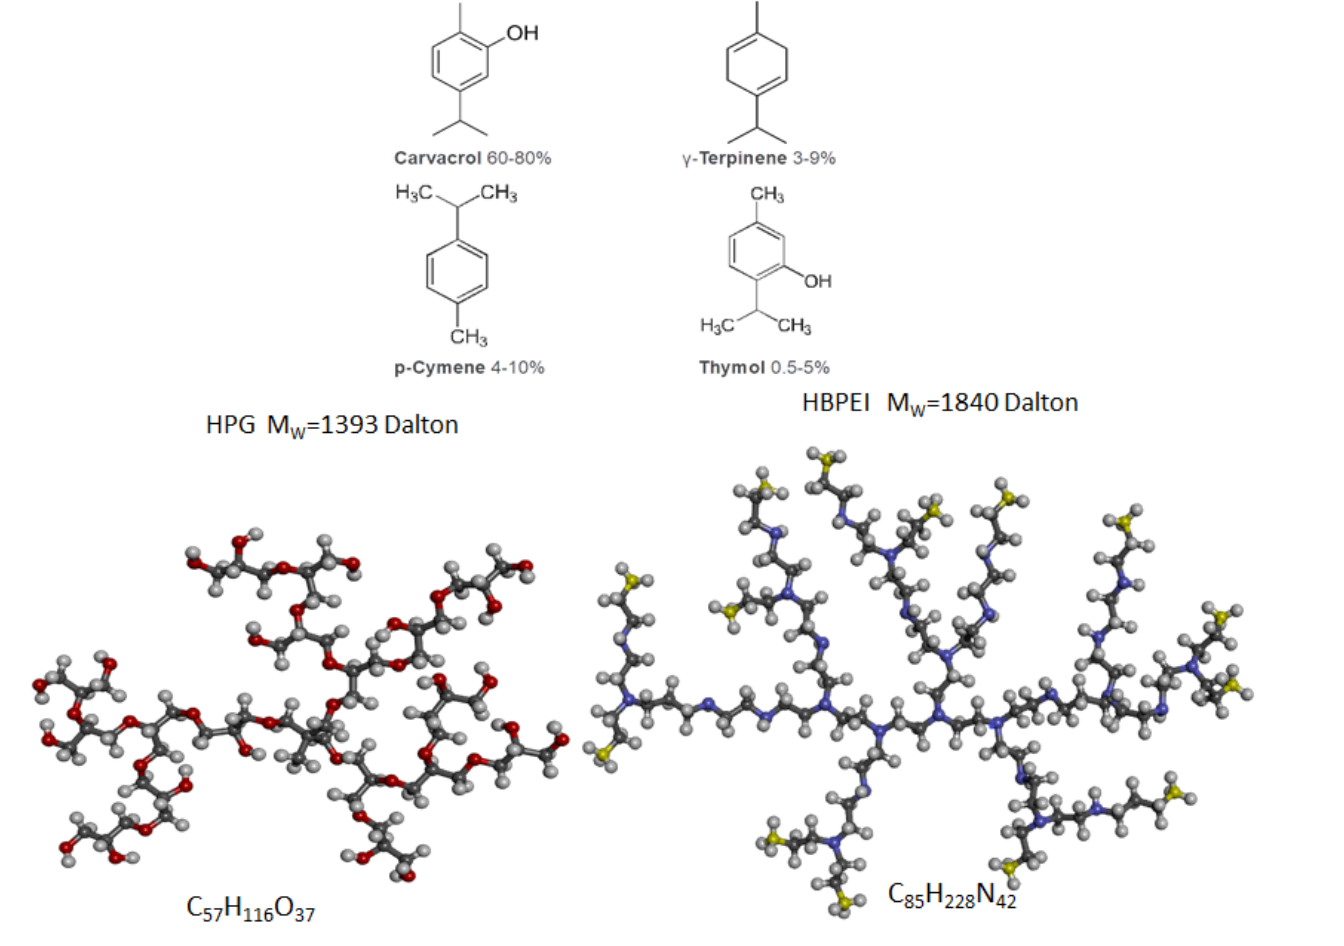
Figure 1. Illustration of the four essential oil ingredients under study ( top ) and candidate drug–carrier hyperbranched polymers ( bottom ). The hyperbranched polymers are shown as ball–stick representations, with hydrogen atoms shown in white, oxygen atoms in red, carbon atoms in grey, non-protonated nitrogen atoms in purple, and protonated nitrogen atoms in yellow.